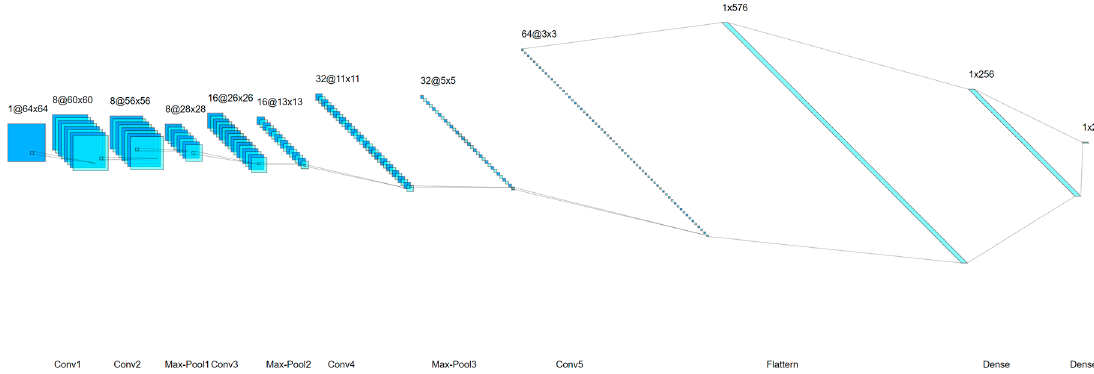
Figure 3. CGFace model with detailed configuration for each layer.